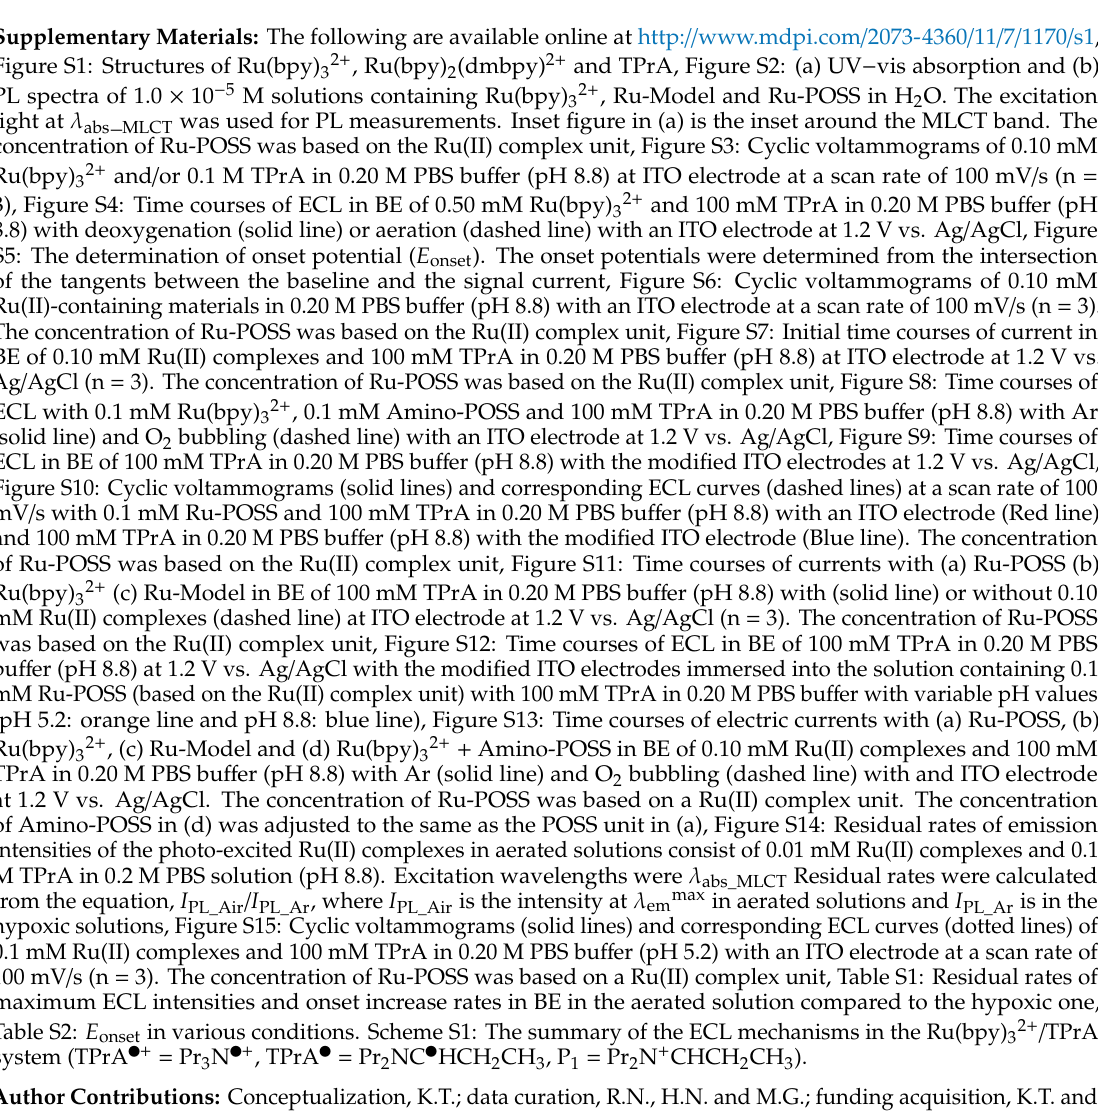
Figure S1: Structures of Ru(bpy) 32 + , Ru(bpy) 2 (dmbpy) 2 + and TPrA, Figure S2: (a) UV − vis absorption and (b) PL spectra of 1.0 × 10 − 5 M solutions containing Ru(bpy) 32 + , Ru-Model and Ru-POSS in H 2 O. The excitation light at λ abs _ MLCT was used for PL measurements. Inset figure in (a) is the inset around the MLCT band. The concentration of Ru-POSS was based on the Ru(II) complex unit, Figure S3: Cyclic voltammograms of 0.10 mM Ru(bpy) 32 + and / or 0.1 M TPrA in 0.20 M PBS bu ff er (pH 8.8) at ITO electrode at a scan rate of 100 mV / s (n = 3), Figure S4: Time courses of ECL in BE of 0.50 mM Ru(bpy) 32 + and 100 mM TPrA in 0.20 M PBS bu ff er (pH 8.8) with deoxygenation (solid line) or aeration (dashed line) with an ITO electrode at 1.2 V vs. Ag / AgCl, Figure S5: The determination of onset potential ( E onset ). The onset potentials were determined from the intersection of the tangents between the baseline and the signal current, Figure S6: Cyclic voltammograms of 0.10 mM Ru(II)-containing materials in 0.20 M PBS bu ff er (pH 8.8) with an ITO electrode at a scan rate of 100 mV / s (n = 3). The concentration of Ru-POSS was based on the Ru(II) complex unit, Figure S7: Initial time courses of current in BE of 0.10 mM Ru(II) complexes and 100 mM TPrA in 0.20 M PBS bu ff er (pH 8.8) at ITO electrode at 1.2 V vs. Ag / AgCl (n = 3). The concentration of Ru-POSS was based on the Ru(II) complex unit, Figure S8: Time courses of ECL with 0.1 mM Ru(bpy) 32 + , 0.1 mM Amino-POSS and 100 mM TPrA in 0.20 M PBS bu ff er (pH 8.8) with Ar (solid line) and O 2 bubbling (dashed line) with an ITO electrode at 1.2 V vs. Ag / AgCl, Figure S9: Time courses of ECL in BE of 100 mM TPrA in 0.20 M PBS bu ff er (pH 8.8) with the modified ITO electrodes at 1.2 V vs. Ag / AgCl, Figure S10: Cyclic voltammograms (solid lines) and corresponding ECL curves (dashed lines) at a scan rate of 100 mV / s with 0.1 mM Ru-POSS and 100 mM TPrA in 0.20 M PBS bu ff er (pH 8.8) with an ITO electrode (Red line) and 100 mM TPrA in 0.20 M PBS bu ff er (pH 8.8) with the modified ITO electrode (Blue line). The concentration of Ru-POSS was based on the Ru(II) complex unit, Figure S11: Time courses of currents with (a) Ru-POSS (b) Ru(bpy) 32 + (c) Ru-Model in BE of 100 mM TPrA in 0.20 M PBS bu ff er (pH 8.8) with (solid line) or without 0.10 mM Ru(II) complexes (dashed line) at ITO electrode at 1.2 V vs. Ag / AgCl (n = 3). The concentration of Ru-POSS was based on the Ru(II) complex unit, Figure S12: Time courses of ECL in BE of 100 mM TPrA in 0.20 M PBS bu ff er (pH 8.8) at 1.2 V vs. Ag / AgCl with the modified ITO electrodes immersed into the solution containing 0.1 mM Ru-POSS (based on the Ru(II) complex unit) with 100 mM TPrA in 0.20 M PBS bu ff er with variable pH values (pH 5.2: orange line and pH 8.8: blue line), Figure S13: Time courses of electric currents with (a) Ru-POSS, (b) Ru(bpy) 32 + , (c) Ru-Model and (d) Ru(bpy) 32 + + Amino-POSS in BE of 0.10 mM Ru(II) complexes and 100 mM TPrA in 0.20 M PBS bu ff er (pH 8.8) with Ar (solid line) and O 2 bubbling (dashed line) with and ITO electrode at 1.2 V vs. Ag / AgCl. The concentration of Ru-POSS was based on a Ru(II) complex unit. The concentration of Amino-POSS in (d) was adjusted to the same as the POSS unit in (a), Figure S14: Residual rates of emission intensities of the photo-excited Ru(II) complexes in aerated solutions consist of 0.01 mM Ru(II) complexes and 0.1 M TPrA in 0.2 M PBS solution (pH 8.8). Excitation wavelengths were λ abs_MLCT Residual rates were calculated from the equation, I PL_Air / I PL_Ar , where I PL_Air is the intensity at λ emmax in aerated solutions and I PL_Ar is in the hypoxic solutions, Figure S15: Cyclic voltammograms (solid lines) and corresponding ECL curves (dotted lines) of 0.1 mM Ru(II) complexes and 100 mM TPrA in 0.20 M PBS bu ff er (pH 5.2) with an ITO electrode at a scan rate of 100 mV / s (n = 3). The concentration of Ru-POSS was based on a Ru(II) complex unit, Table S1: Residual rates of maximum ECL intensities and onset increase rates in BE in the aerated solution compared to the hypoxic one, Table S2: E onset in various conditions. Scheme S1: The summary of the ECL mechanisms in the Ru(bpy) 32 + / TPrA system (TPrA (cid:8) + = Pr 3 N (cid:8) + , TPrA (cid:8) = Pr 2 NC (cid:8) HCH 2 CH 3 , P 1 = Pr 2 N + CHCH 2 CH 3